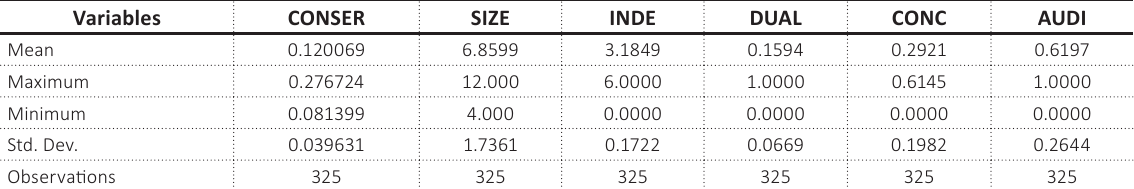
Table 1. Descriptive statistics